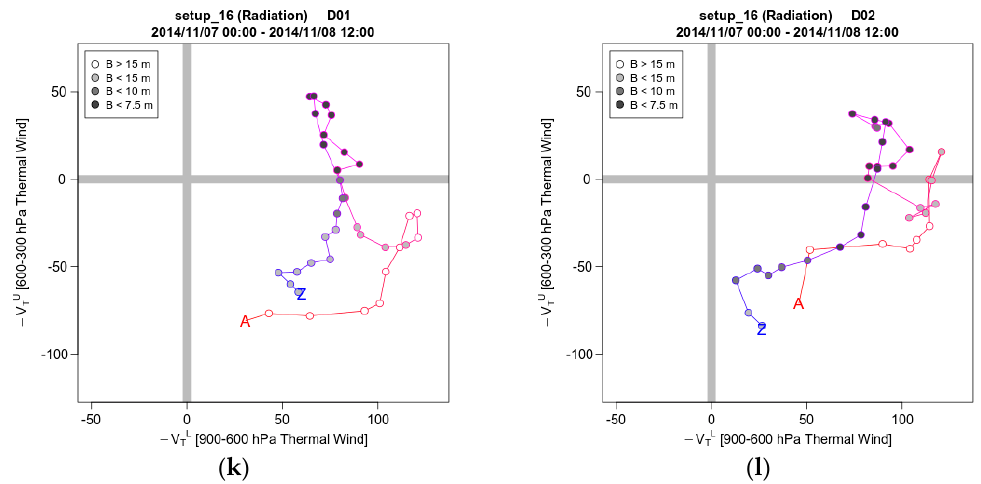
Figure 13. Phase space diagrams of − V TL (900–600 hPa) against –V TU (600–300 hPa) as predicted from model CU/RAD experiments in D01 for: ( a ) setup_10, ( c ) setup_11, ( e ) setup_12, ( g ) setup_13, ( i ) setup_15, ( k ) setup_16 and in D02 for: ( b ) setup_10, ( d ) setup_11, ( f ) setup_12, ( h ) setup_13, ( j ) setup_15, ( l ) setup_16. Circles show the position at hourly intervals while filled circles denote the position when the symmetry is less than 10 m.